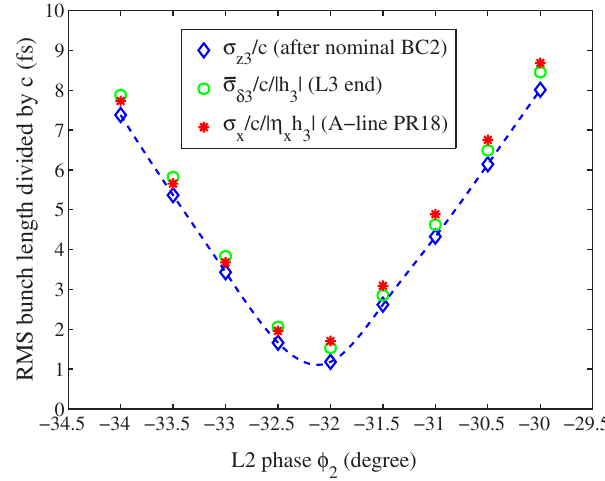
FIG. 8. ELEGANT simulations of rms bunch length for the LCLS 20-pC bunch after BC2 (5% cut in current, energy, or horizontal distributions, BC2 R 56 ¼ (cid:2) 24 : 7 mm for operation and R 56 ¼ (cid:2) 32 : 78 mm for bunch length Fig. 5, we introduce correlations in x (cid:2) z and x 0 (cid:2) z at locations where the bunch length is small to reduce the CSR effects.